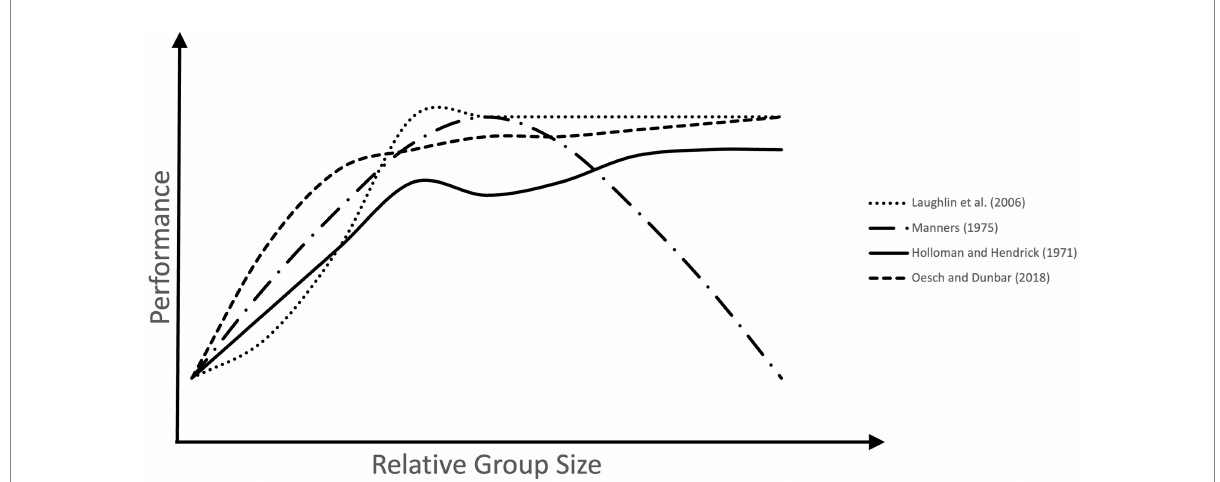
FIGURE 2 Group size effects on performance across several human studies. The measures of problem-solving performance used across these studies differed. These were, latency to solution (Laughlin et al., 2006), effectiveness (Manners, 1975), accuracy of decisions (Holloman and Hendrick, 1971), and foraging efficiency (Oesch and Dunbar, 2018). In all cases performance increases as small groups increase in size. However, in larger groups performance either decreases above an optimal size, or plateaus, with the benefit of more participants stagnating after a certain group